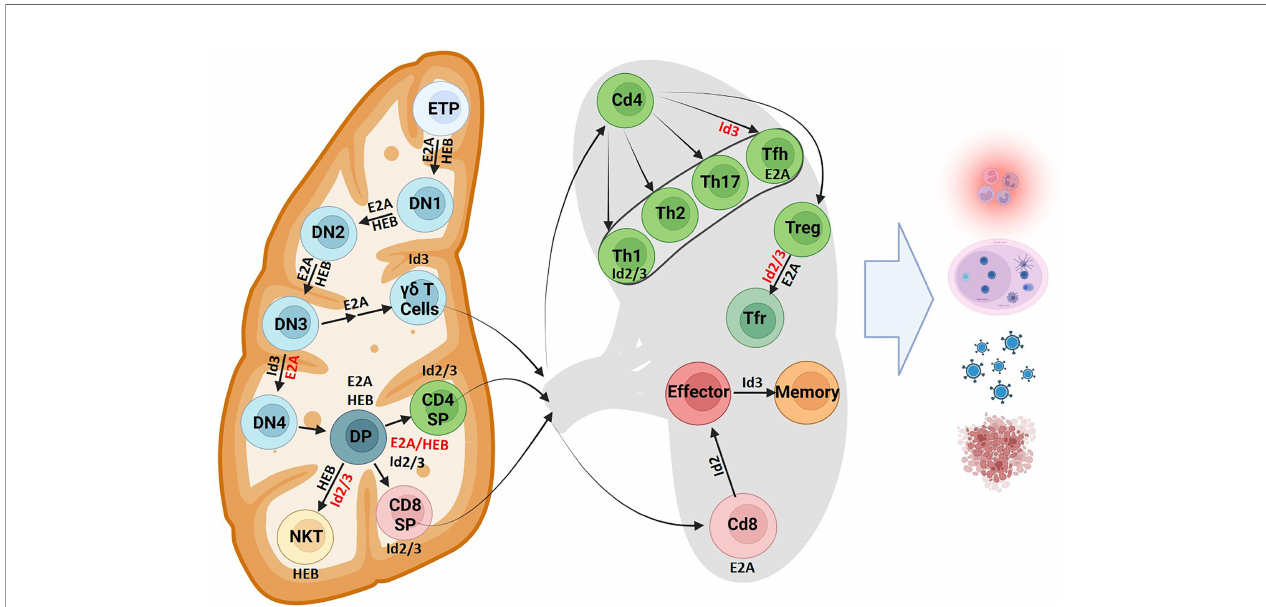
FIGURE 4 | T cell fate and differentiation is directed by E protein activity. The role of E proteins and their antagonists in T cell development is shown in the thymus and lymphoid organs. Protein factors supportive of differentiation or cell maintenance are indicated in black font next to the arrows or adjacent to the cell respectively. Protein factors with repressive functions are indicated in red font (Created with